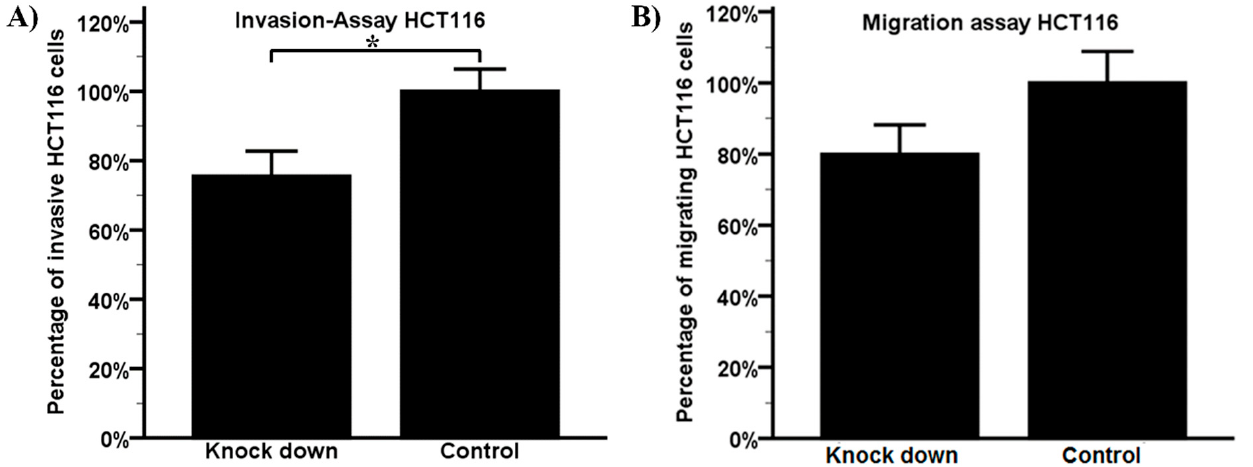
Figure 3. Invasion ( A ) and migration ( B ) assays. Granulin siRNA-transfected HCT-116 cells were less migratory ( p = 0.074) and significantly less invasive (* p = 0.013). Bars represent mean +